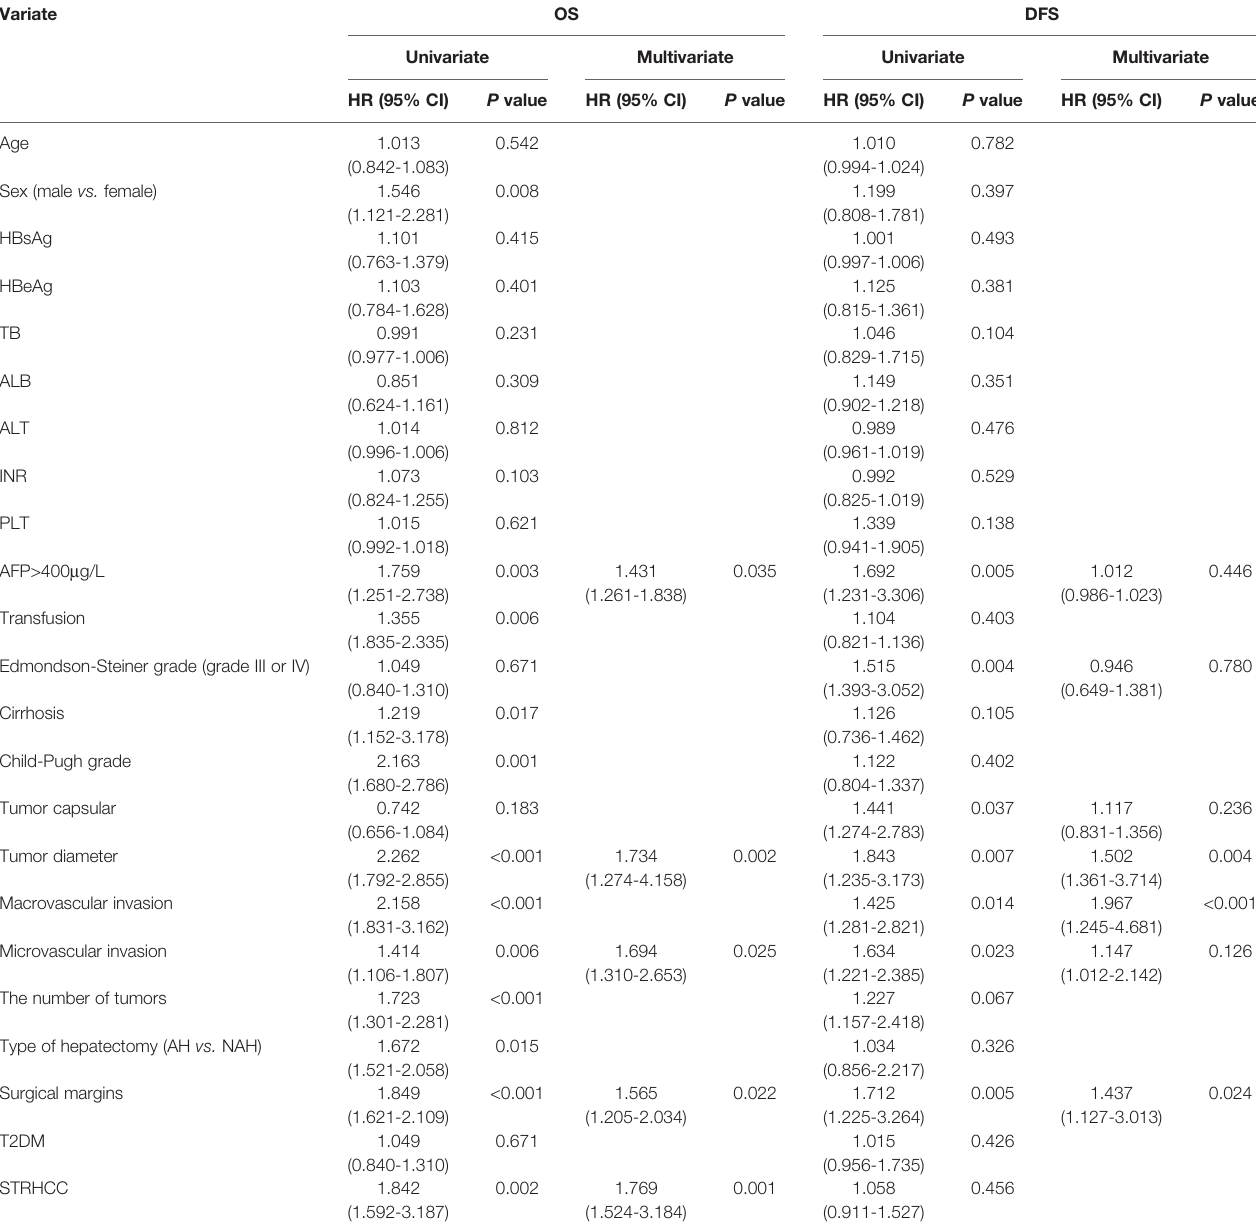
TABLE 4 | Univariate and multivariate regression analysis of prognostic factors for OS and DFS in 178 HCC patients after